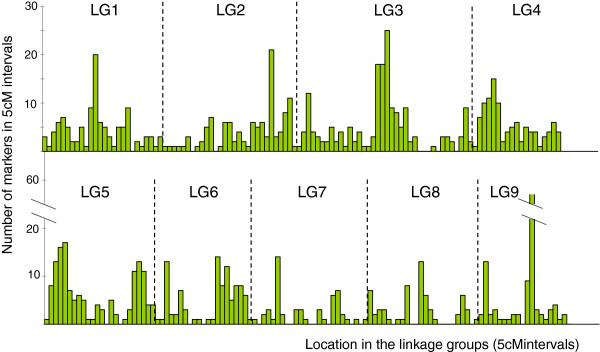
Density of markers along the ‘Nules’ Clementine genetic map.